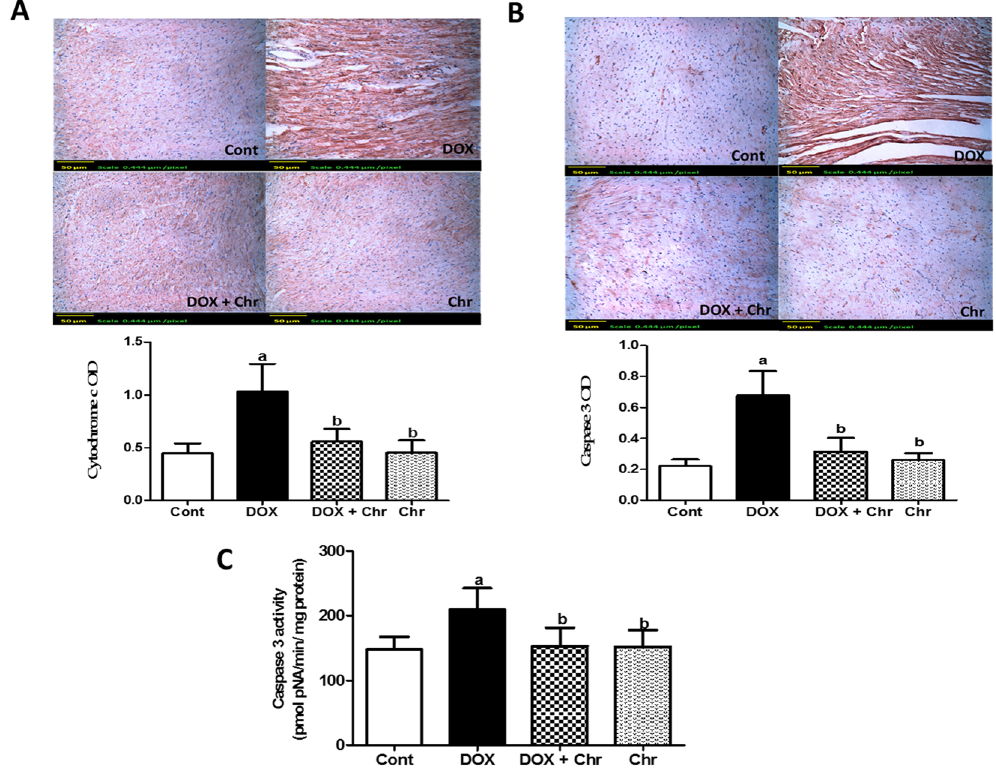
Figure 5. Effect of chrysin on cytochrome c and caspase 3 protein expressions and activity in rats subjected to chronic doxorubicin (DOX) intoxication. ( A ) Protein expression of cytochrome c by immunohistochemical staining. ( B ) Protein expression of caspase 3 by immunohistochemical staining. Scale bar, 50 µ m (200x) and quantitative image analysis for immunohistochemical staining was expressed as optical densities (OD) across 10 different fields for each rat section. ( C ) Caspase 3 activity expressed as pmolpNA/min/mg protein. Data are represented as as mean ± SD (n = 10). a or b: Statistically significant from the control or DOX group respectively at P < 0.05 using one-way analysis of variance ANOVA followed by Tukey-Kramer as a post-hoc